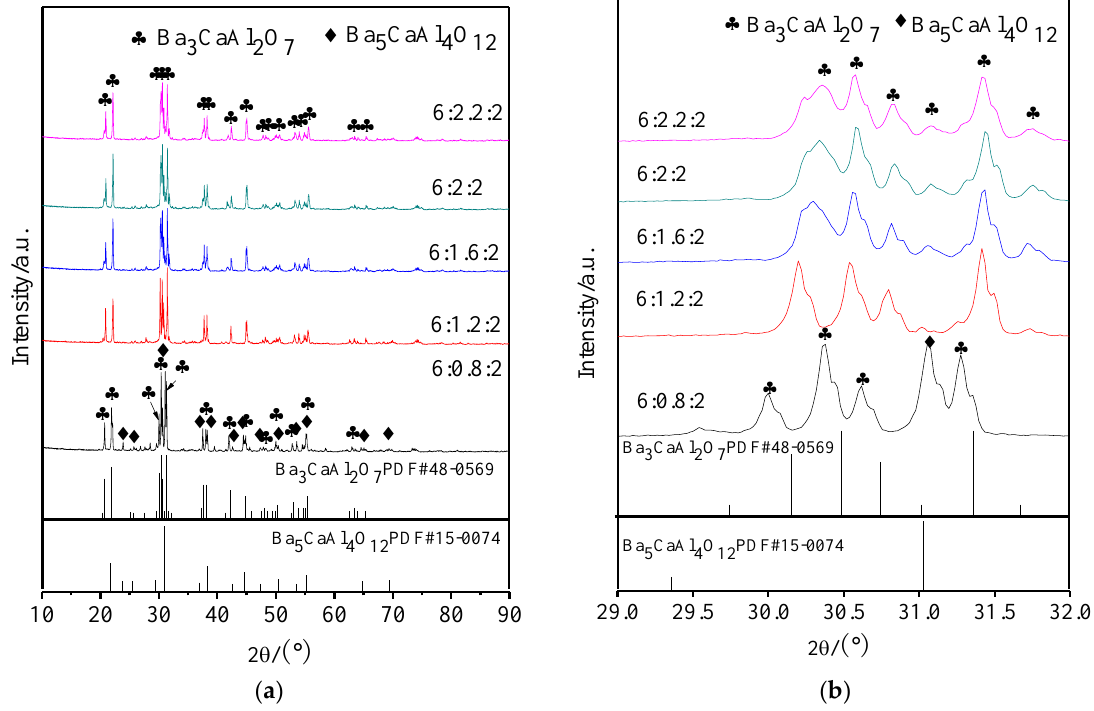
Figure 1. X-ray powder diffractometer (XRD) patterns of 6BaO·xCaO·2Al 2 O 3 aluminates. ( a ) XRD patterns in 10~90°; and, ( b ) Partial enlarged drawing in 29~32° of ( a ).